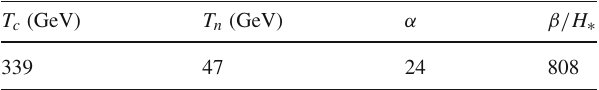
Fig. 5 The blue solid line presents S 3 / T versus T , and the dashed horizontal red line shows S 3 / T = 140 where nucleation occurs. The green dots are obtained using AnyBubble package Table 2 Parameters of the phase transition for the benchmark point in Table